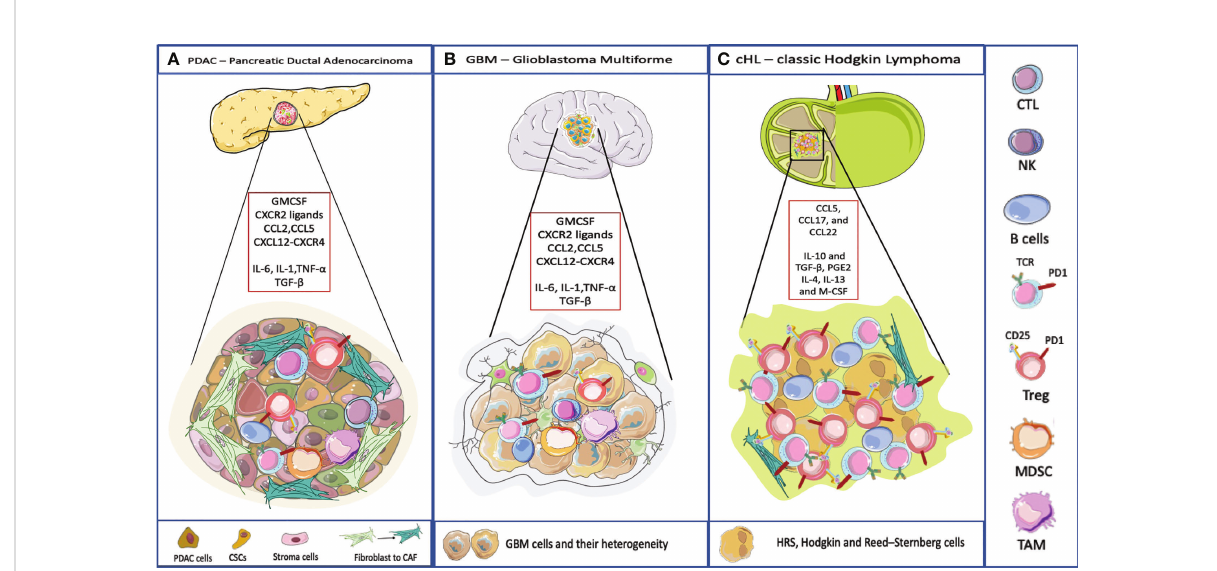
FIGURE 2 TME and its composition in three different cancer model. (A) PDAC TME is characterized by a dense stroma, CAFs, and immune cells populations that crosstalk to the subpopulations of neoplastic cells that include cancer stem cells (CSCs). Pancreatic cancer cells typically express one or more mutated oncogenes or tumor suppressor genes ( e.g. KRAS , TP53 , CDKN2A , and SMAD4 ) that can interact with the TME, regulating stromal cells and the ECM in direct and indirect ways. The TME has highly diverse cellular and extracellular components. The CAFs are responsible for the secretion of extracellular matrix and soluble molecules which create a TME that favors tumor growth and resistance to the therapy. The TME is highly immunosuppressive, with the in fi ltration of TAMs, MDSC and Treg. The accumulation of CD4+ T cells and B cells contribute to carcinogenesis too. The soluble molecules released by PDAC cells or immune cells recreate an immunosuppressive microenvironment. IL-6, IL-1, TNF- a favor the polarization of macrophages into TAMs and they promote MDSC function, through the secretion of ECM. TGF- b is released by cancer cells and by immunosuppressive cells to favor a pro-tumoral environment. Here are represented some chemokines responsible for the recruitment of immune cells into the tumor, and involved in the redirection of the T cells, for example CCL5 attracts Tregs, CXCL12-CXCR4 restricts lymphocyte migration and keeps CTLs outside the tumor. (B) The TME surrounding malignant GBM is very complex. Indeed, the interaction between the immune system and the brain interior is problematic because of the presence of the blood- brain barrier. Even though, also in GBM the TME plays an important role. The GBM cells are heterogeneic they present antigen to CD4 and CD8 T cells that usually are dysfunctional and exhausted. Few B cells in fi ltrate in the brain. Moreover, GBM is characterized by an immunosuppressive and in fl ammatory microenvironment composed of cytokines (IL6, IL1- b , TGF- b , IL-10 and prostaglandin E2), chemokines, and regulatory immune-suppressive cells (Treg, TAMs, and MDSCs). Leukocyte recruitment to the tumor site is mediated by in fl ammatory chemokines from the CXC subfamily and CC group which attract leukocytes within tumor and exert pro- or anti-tumoral effects. CXCL8 is one of the in fl ammatory chemokines and the axis CXCL8-CXCR1/2 axis belongs to the most important and the best recognized regulatory factors in the development of CNS tumors. Moreover, CXCL8, CCL2, IL-6, contribute to MDSC generation (45). (C) cHL is characterized by a peculiar TME, most of the tumor is represented by dysfunctional T lymphocytes and by immunosuppressive cellular and acellular components. IL-10 and TGF- b , produced by RS, allow the accumulation of Tregs involved in the suppression of the activity of effector cells. IL-10 is a potent immune suppressive cytokine. Levels of IL-10 are elevated in up to a half of cHL patients and are correlated to disease aggressiveness and poor response to therapy. TGF- b production contributes to depress T-cell proliferation, cytokine release, and cytolytic activity. The soluble factor, prostaglandin E2 (PGE2), interferes with T cell receptor signaling, and decreases the cytotoxic response. IL-4, IL-13 and M-CSF attract myeloid cells and polarize macrophages into MDSC and TAMs